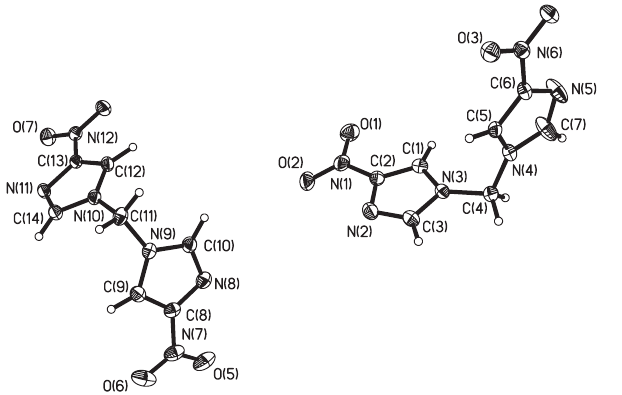
Table 1: Data collection and handling.